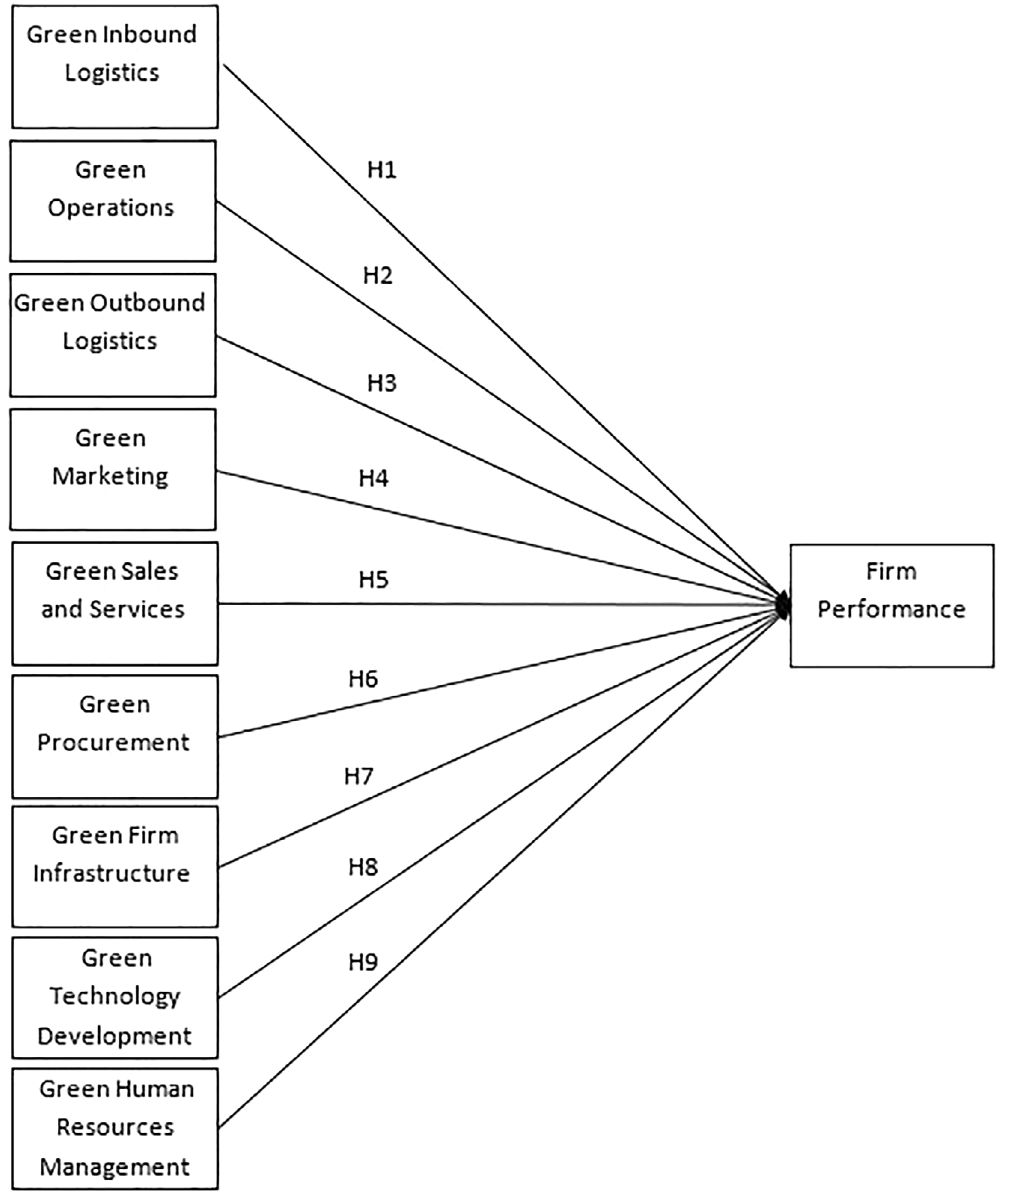
H2: The green operations has a significant positive impact on firm performance. H3: The green outbound logistics has a significant positive impact on firm performance. H4: The green marketing has a significant positive impact on firm performance. H5: The green sales and services has a significant positive impact on firm performance. H6: The green procurement has a significant positive impact on firm performance. H7: The green firm infrastructure has a significant positive impact on firm performance. H8: The green technology development has a significant positive impact on firm performance. H9: The green human resources development has a significant positive impact on firm